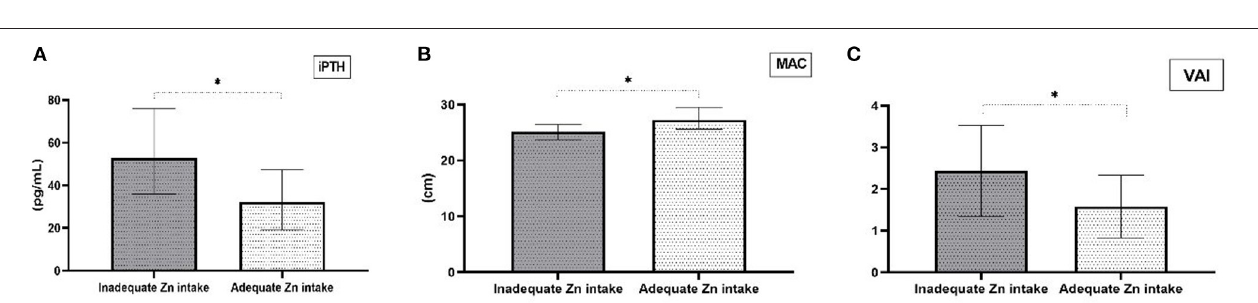
FIGURE 2 | Differences in clinical and anthropometric parameters comparing groups with adequate and inadequate dietary Zn intake. (A) Median values for intact parathyroid hormone (iPTH) levels (1st-3 rd interquartile for inadequate Zn intake = 36–75.9; 1st-3rd interquartile for adequate Zn intake = 19–47.3), (B) Median values for mid-arm circumference (MAC) (1st-3rd interquartile for inadequate Zn intake = 23.7–26.5; 1st-3rd interquartile for adequate Zn intake = 25.6–29.55), and (C) Mean ± standard deviation for visceral adiposity index (VAI). * p < 0.05 for inadequate Zn intake vs adequate Zn intake.